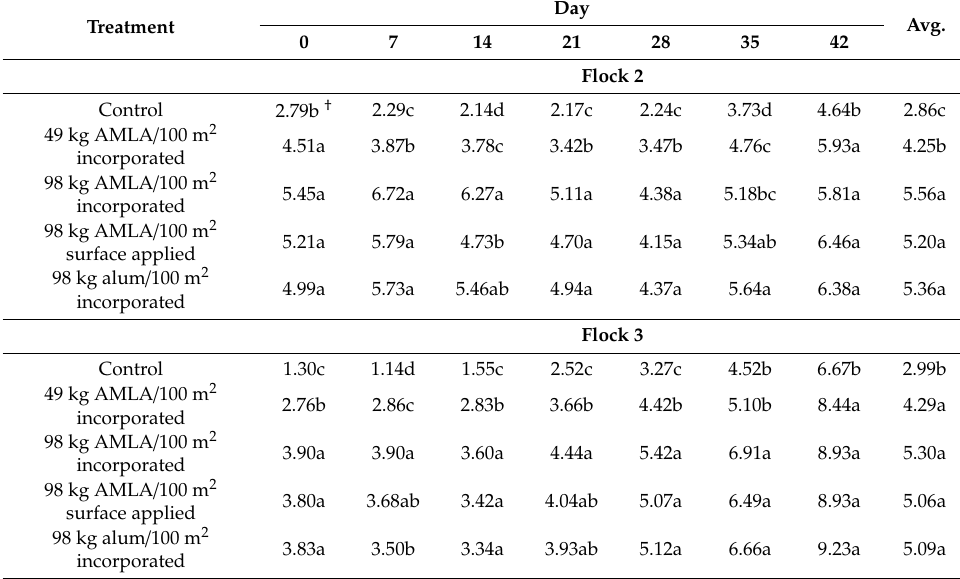
Table 3. Litter ammonium (g NH 4 -N kg − 1 ) for flock 2 and 3 by treatment by